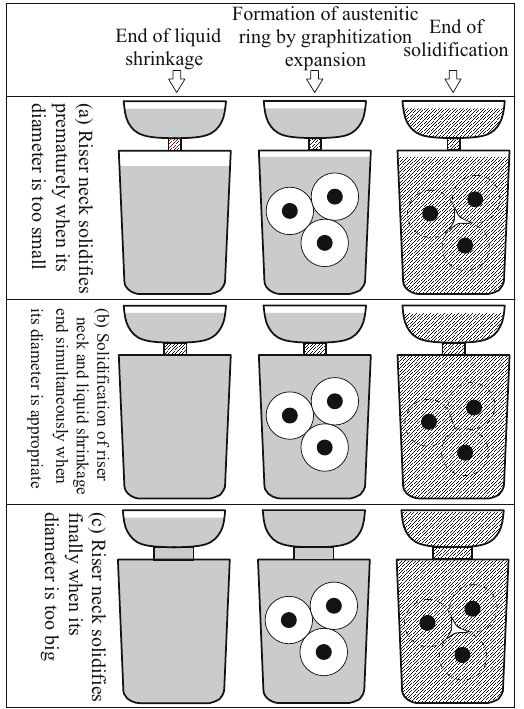
Figure 7: Schematic diagram of the formation process of micro - shrinkage porosity of nodular cast